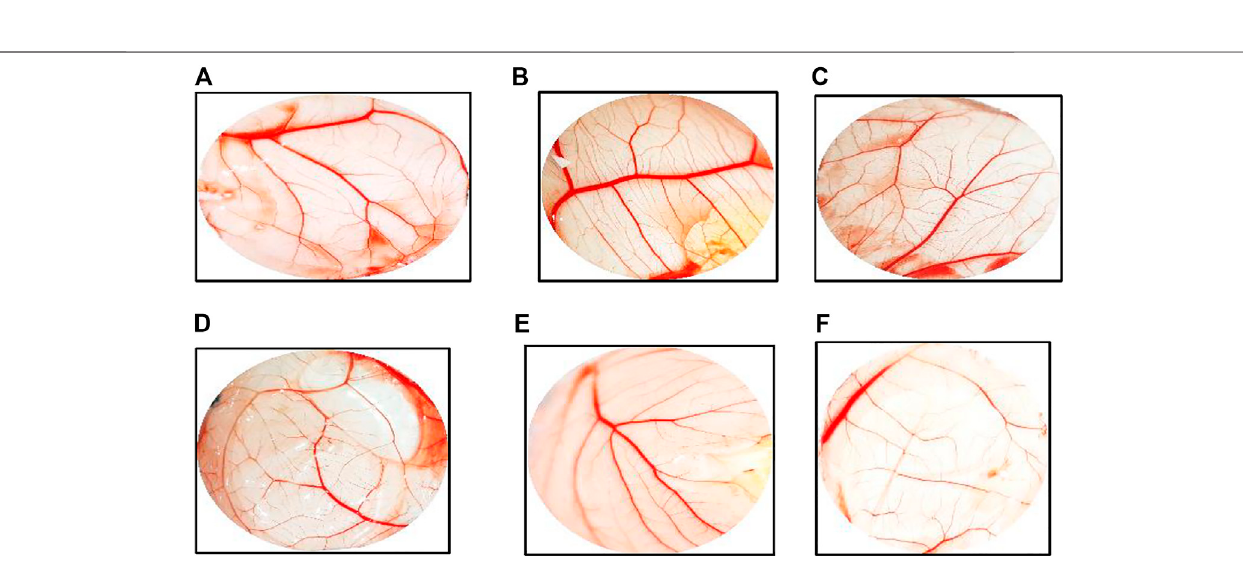
FIGURE10| Chicken chorioallantoic membrane (CAM)assay. (A) Negativecontrol (non-treated). (B) CAM treated with10 μ g/ml ofZnO nanorods (ZnO-NRs). (C) CAM treated with 20 μ g/ml of ZnO nanorods (ZnO-NRs). (D) CAM treated with 10 ng of positive control VEGF. (E) CAM treated with 50 μ g/ml of ZnO nanorods (ZnO- NRs). (F) CAM treated with released Zn (II)